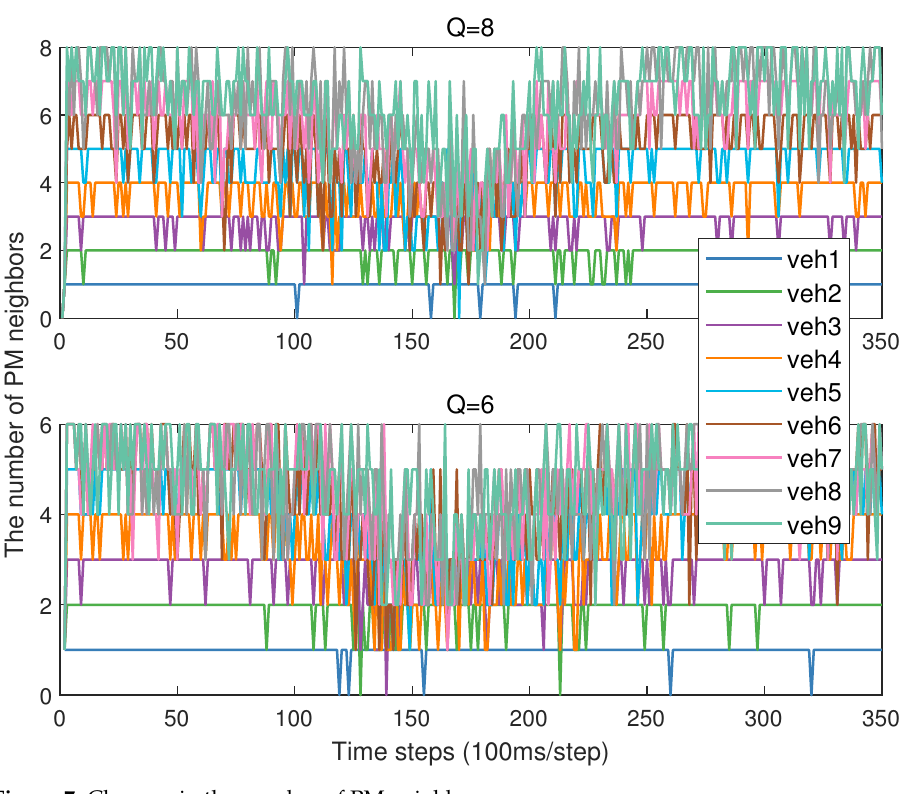
Figure 7. Changes in the number of PM neighbors.